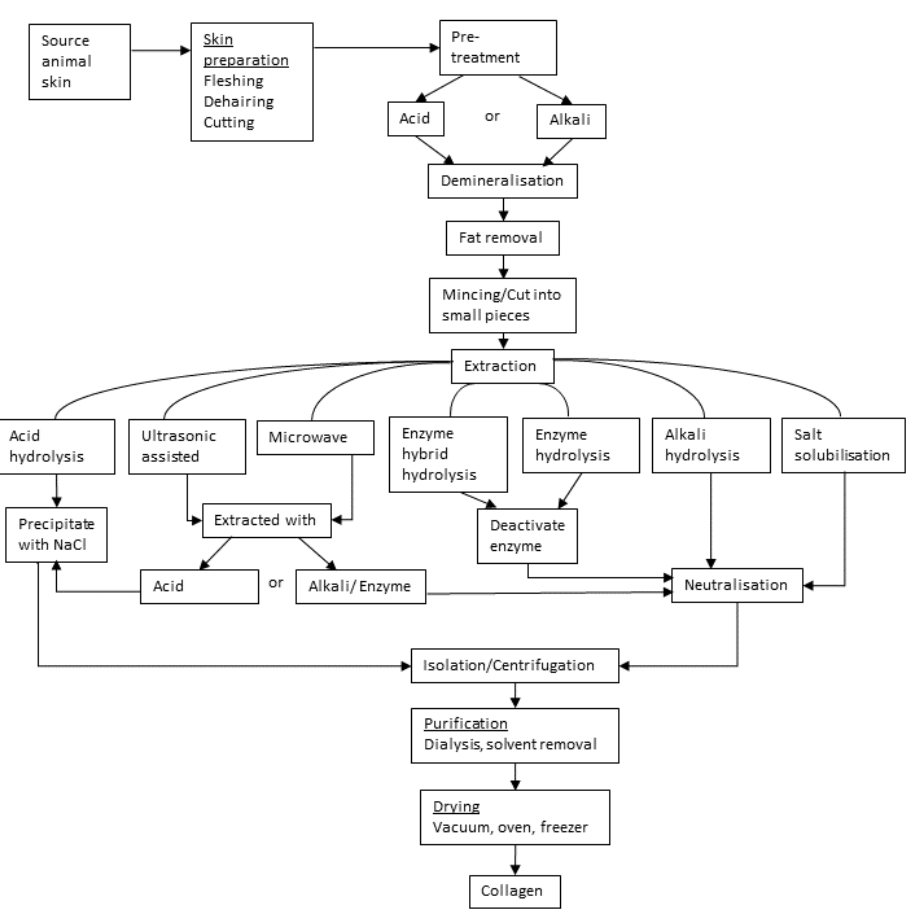
Figure 4. Overview of processing options for extraction of collagen from skin (based on Table 3).